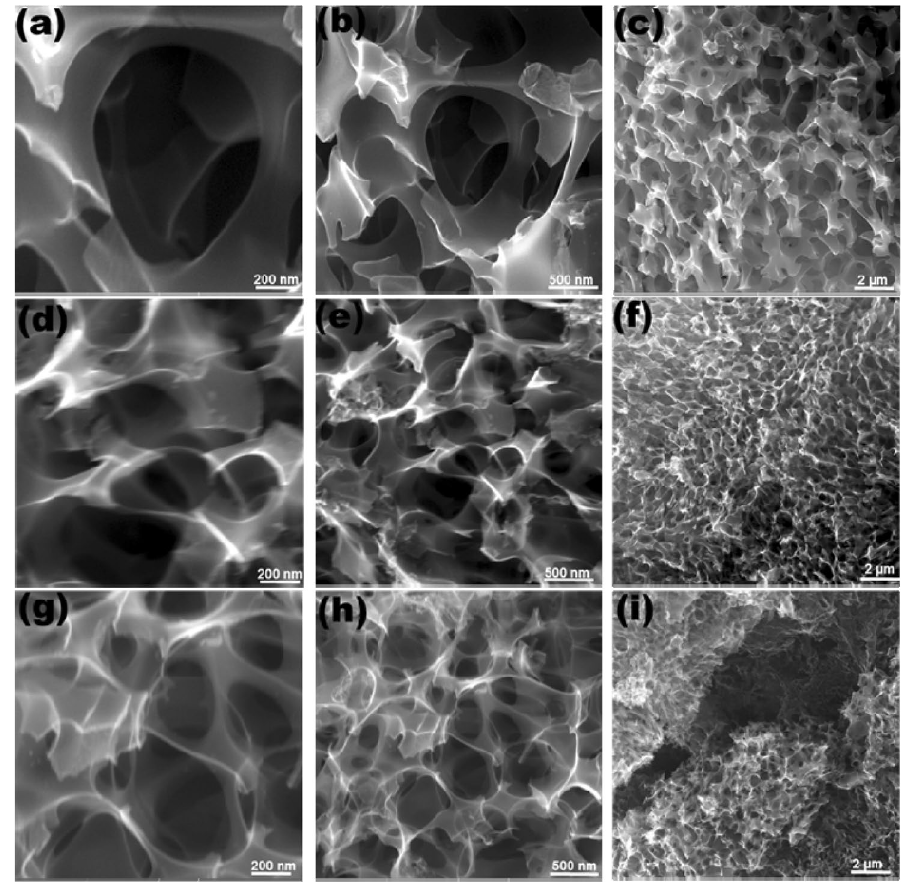
Figure 1. FESEM images at different magnification of CNS prepared at 650 °C from nettle stems ( a – c ) and leaves ( d – i ) using NaHCO 3 as an activating agent. The ratio of nettle powder and NaHCO 3 is 1:1 ( a – f ) and 1:2 ( g – i